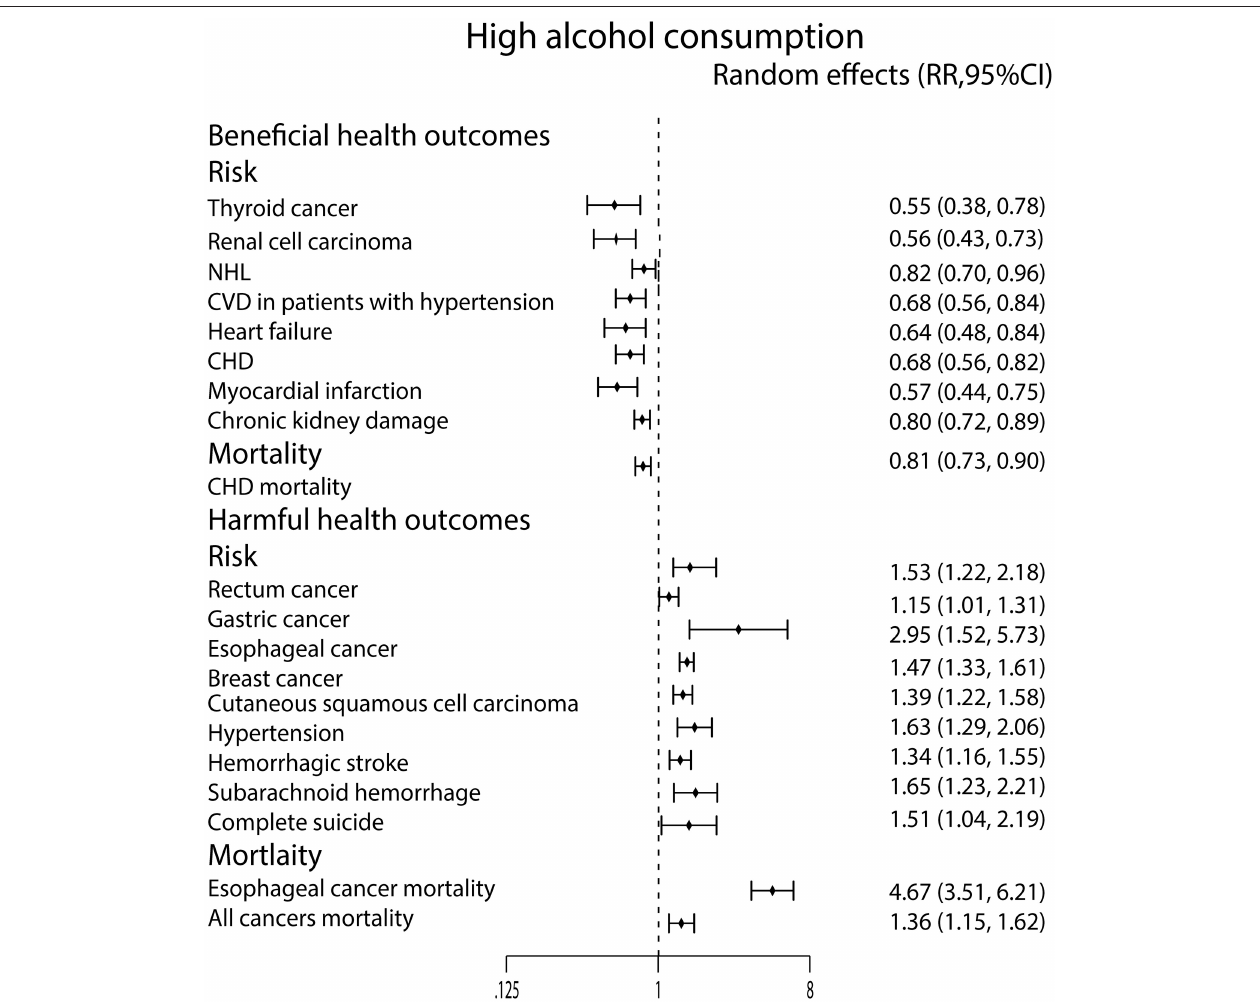
FIGURE 5 | Forest plot: recalculated effects estimates of meta-analyses reporting significant associations of high alcohol consumption with health outcomes. RR, relative risk; CI, confidence interval; CVD, cardiovascular disease; CHD, coronary heart